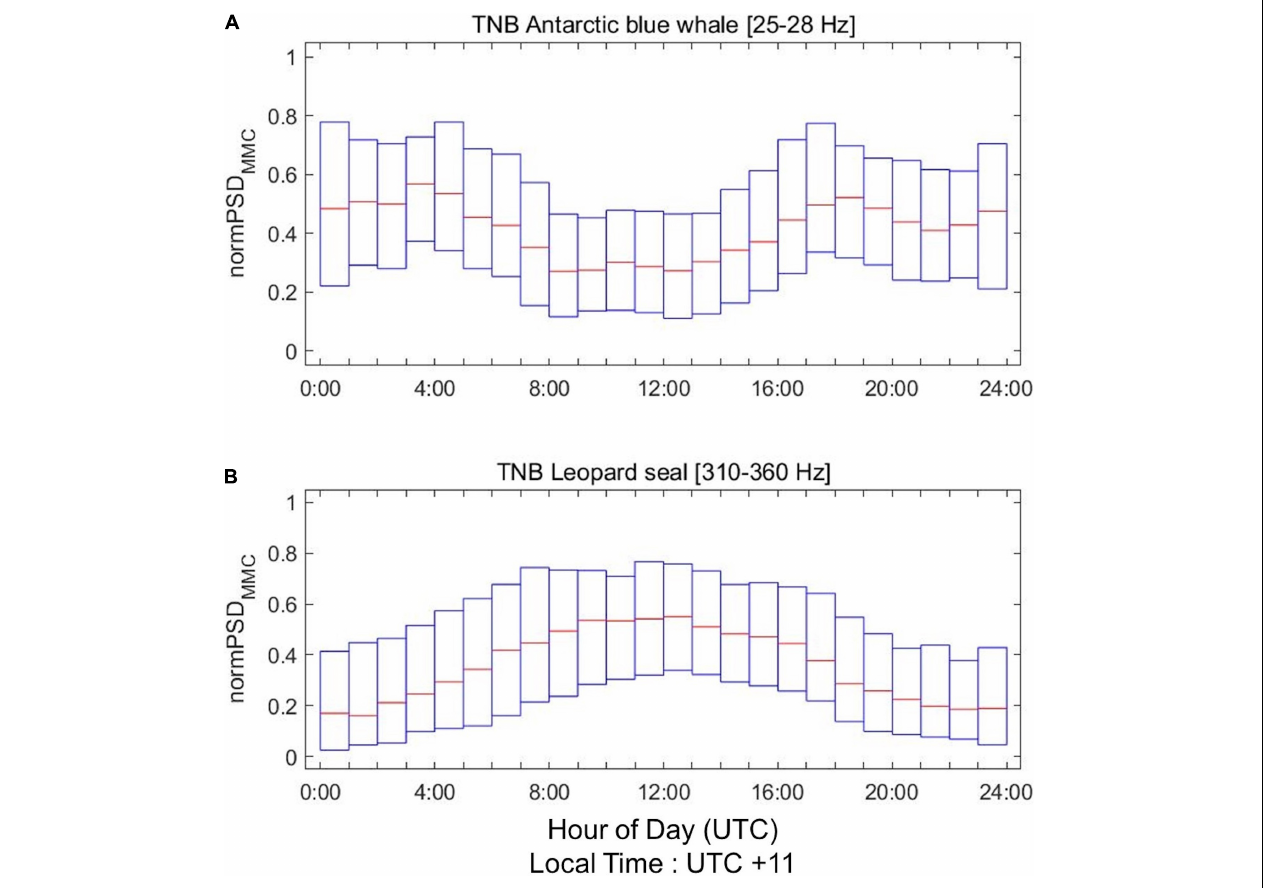
FIGURE 7 | Same as Figure 6 but for the (A) Antarctic blue whales and (B) leopard seals in the